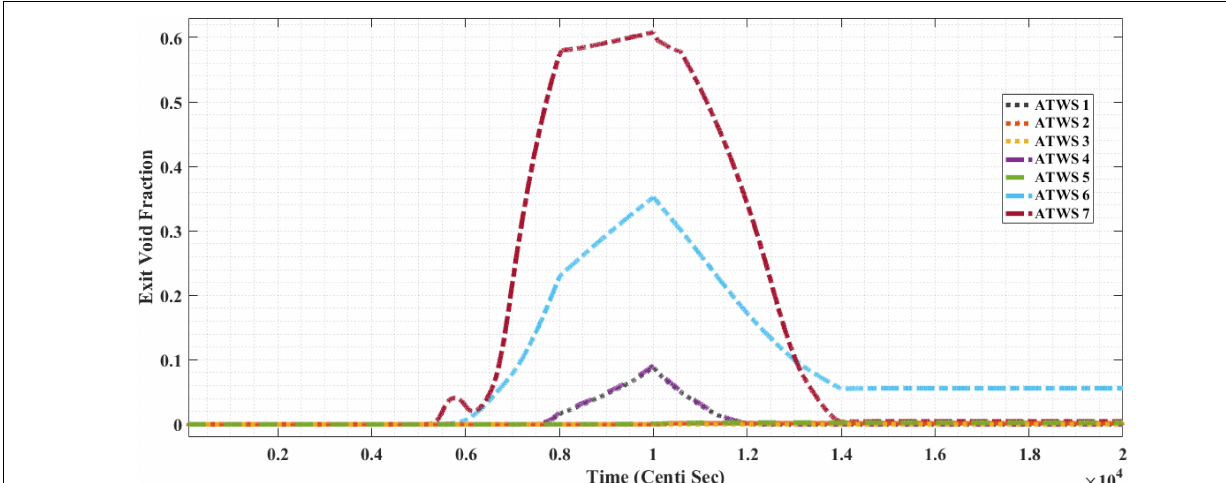
FIGURE 9 | Exit void fraction during ATWS scenarios.